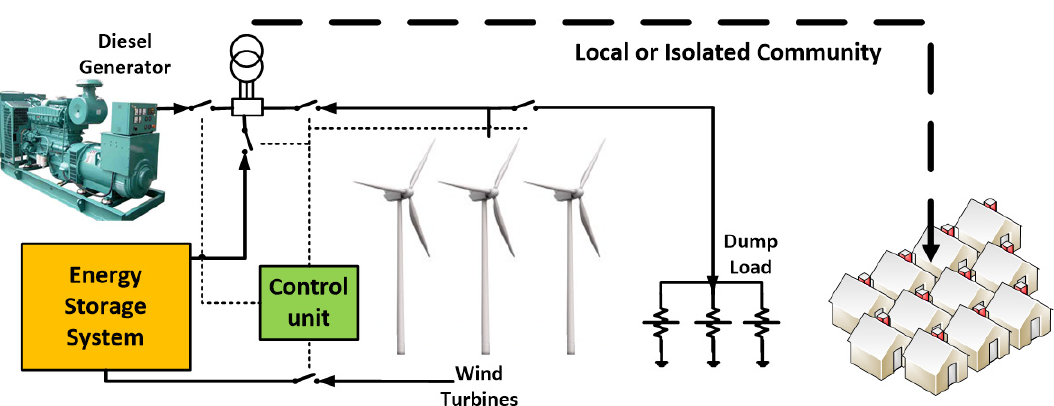
Figure 3. Schematic of the proposed hybrid